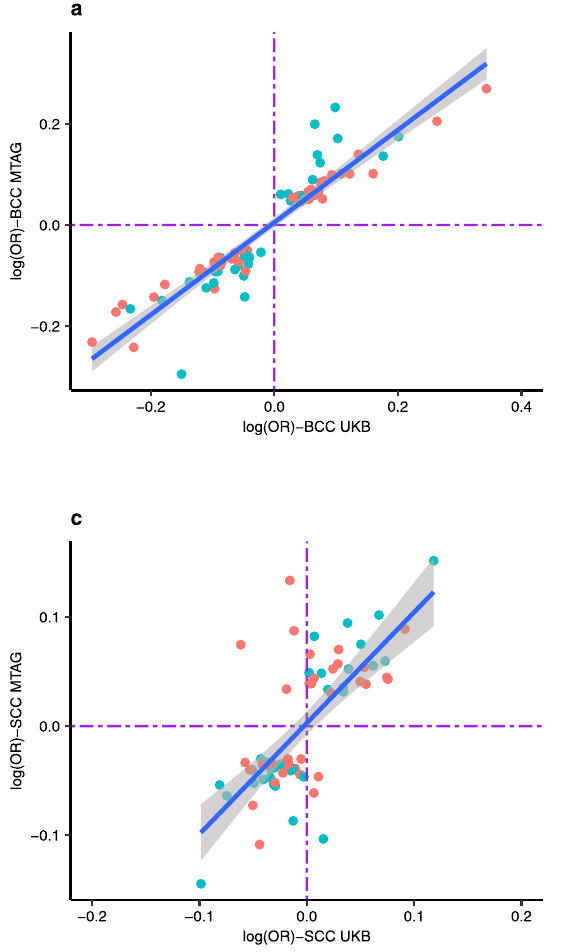
BCC effect estimates, yielding a high concordance with a Pearson ’ s correlation of 0.93(95%con fi denceinterval[CI]=0.89 – 0.96,two-sidedtest). b ShowsBCCMTAG versusBCCreplication(23andMe)effectestimates,yieldingahighconcordancei.e. Pearson ’ s correlation=0.97 (95% CI=0.95 – 0.98, two-sided test). c Shows SCC MTAG versus UKB SCC effect estimates, yielding a high concordance; Pearson ’ s correlation=0.71, 95% CI=0.57 – 0.81, two-sided test). d Shows SCC MTAG versus SCC replication effect estimates, also resulting in a high correlation i.e. 0.69 (95% CI=0.55 – 0.80, two-sided test). UKB- United Kingdom Biobank, and MTAG- multi- trait analysis of GWAS. Source data are provided as a Source Data fi